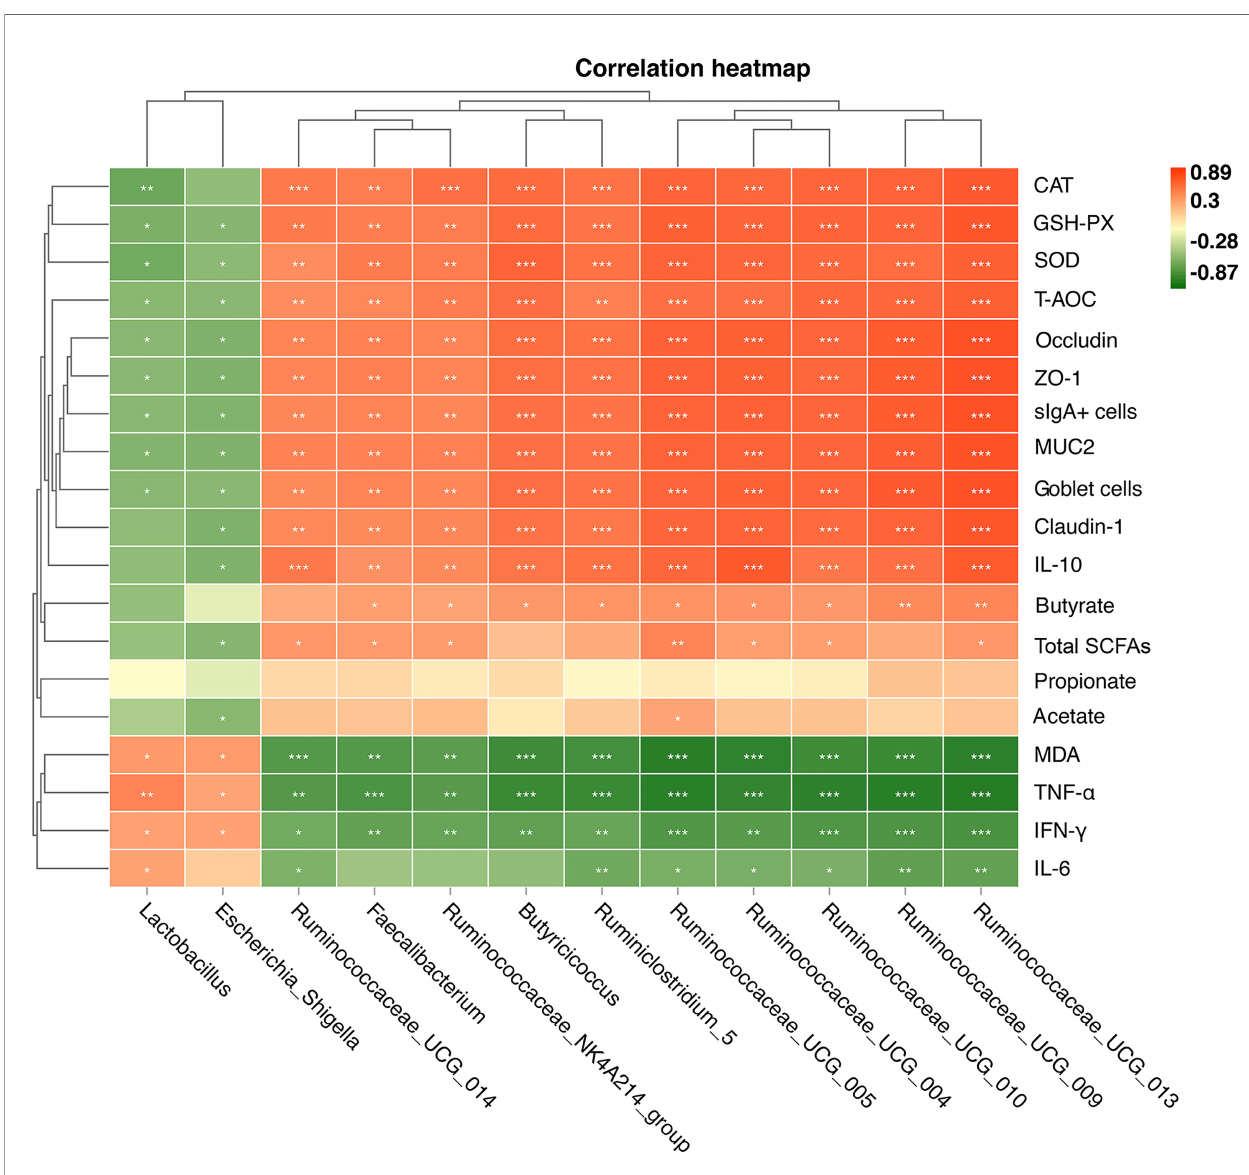
FIGURE 9 | Heat map of Spearman ’ s correlation between the relative abundances of 12 key genus and phenotypic variables (A) . These 12 key genera were notably signi fi cantly different bacteria at the genus level in the chick cecum of WW, RR, GG, BB, and G ! B groups at P42. The colors range from green (negative correlations) to red (positive correlations). WW, white light; RR, red light; GG, green light; BB, blue light; G ! B, green light and blue light combination. * P < 0.05; ** P < 0.01; *** P <